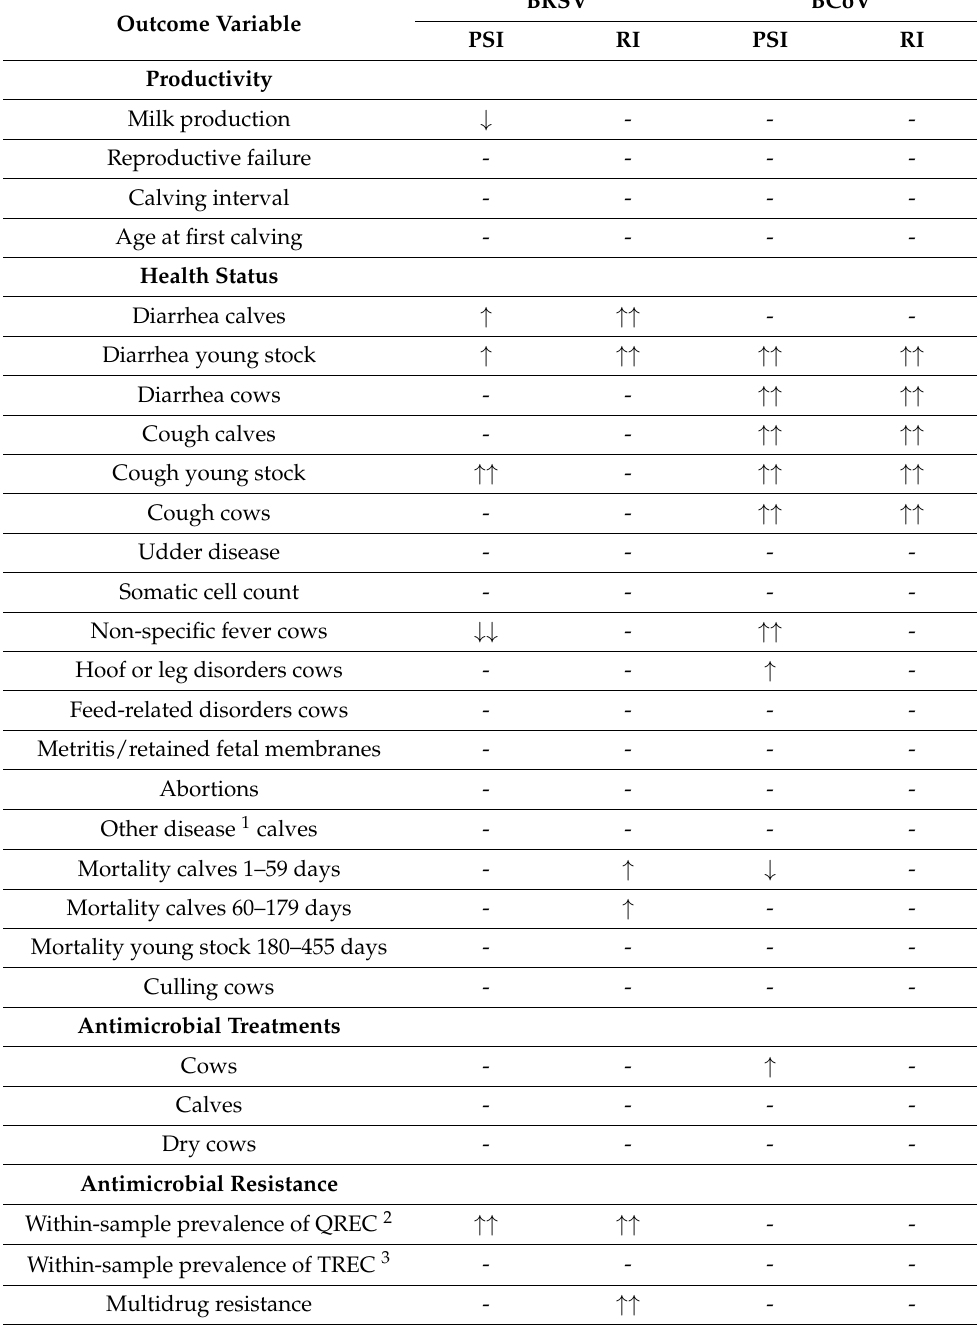
Table 2. A schematic overview of the effects of infection status (PSI or RI) for bovine respiratory syncytial virus (BRSV) or bovine coronavirus (BCoV) infection on different outcomes related to herds with a FREE status. Upwards arrow denotes a higher value than in herds with a FREE status and downwards a lower value. Two arrows denote a statistically significant effect ( p < 0.05), one arrow a statistical trend (0.05 < p < 0.1), and a dash neither a statistically significant effect nor a statistical trend ( p >